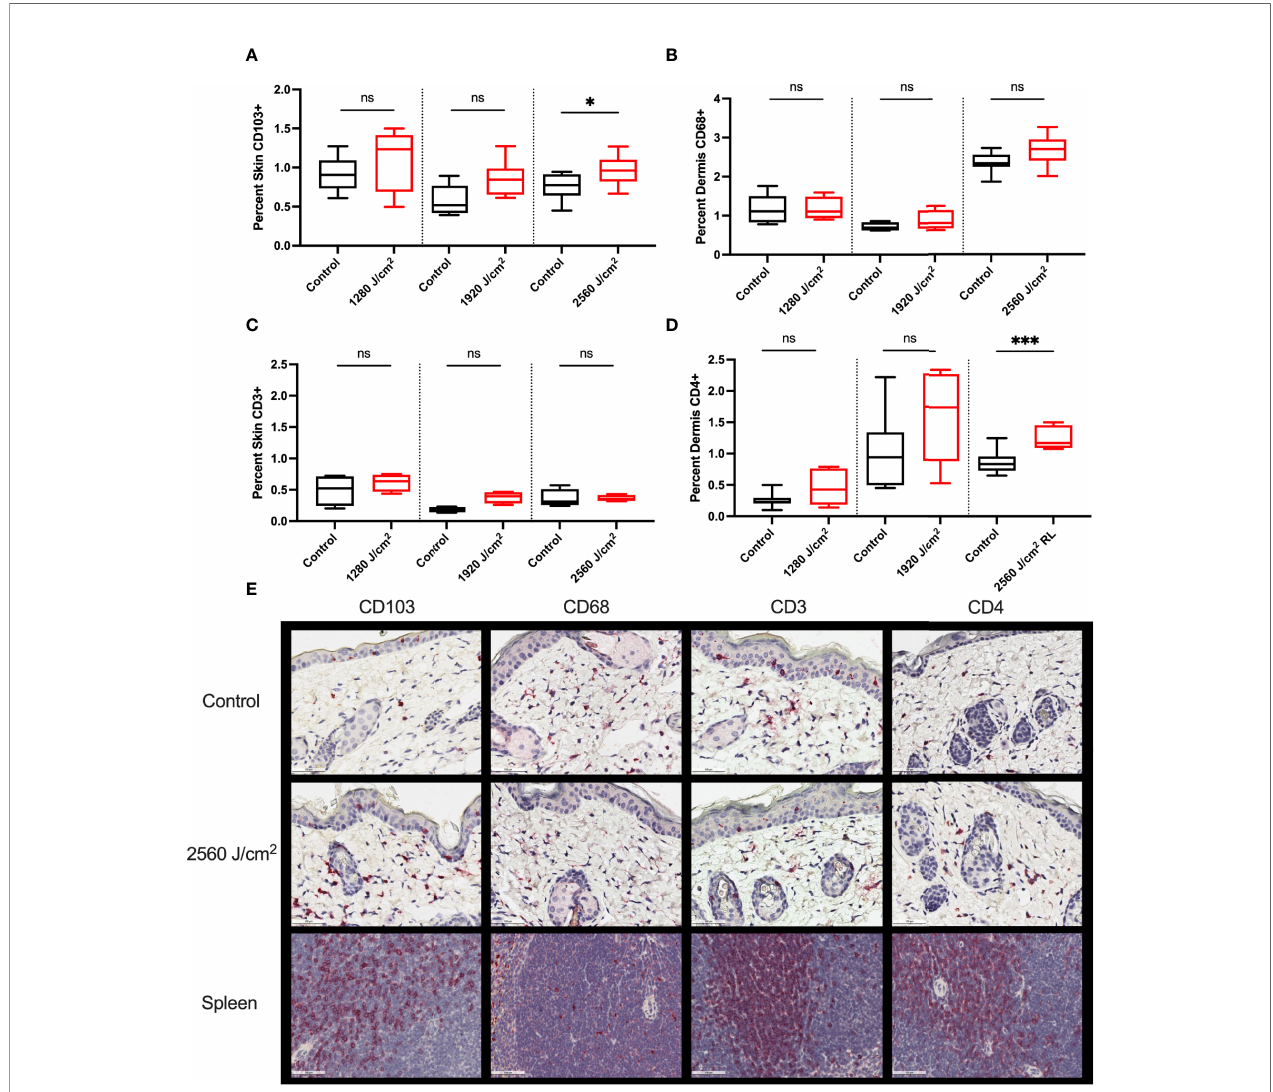
FIGURE 6 | RL increases the expression of immunocyte markers. (A) Quanti fi cation of CD103 (n=8), (B) CD68 (n=5 for 1280 J/cm 2 , n=4 for 1920 J/cm 2 , n=8 for 2560 J/cm 2 ), (C) CD3 (n=4), and (D) CD4 (n=8) staining in the peritumoral dermis or skin from 1280, 1920, and 2560 J/cm 2 RL-treated and control C57BL/6 mice injected with B16F10 cells (two-tailed T-Test, p<0.05). (E) Representative IHC for CD103, CD68, CD3, and CD4 positive staining peritumoral dermis and skin. The staining intensity of each marker was indexed to the total skin or dermal area for each section. Spleen positive control tissue is provided. Staining was quanti fi ed using Indica HALO software and compared to total skin or dermal area. * denotes p<0.05, *** denotes p<0.001, ns denotes not signi fi